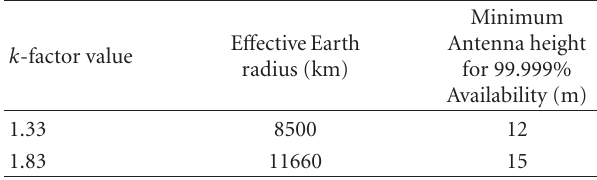
Table 2: MW link availability corresponding to k -factor